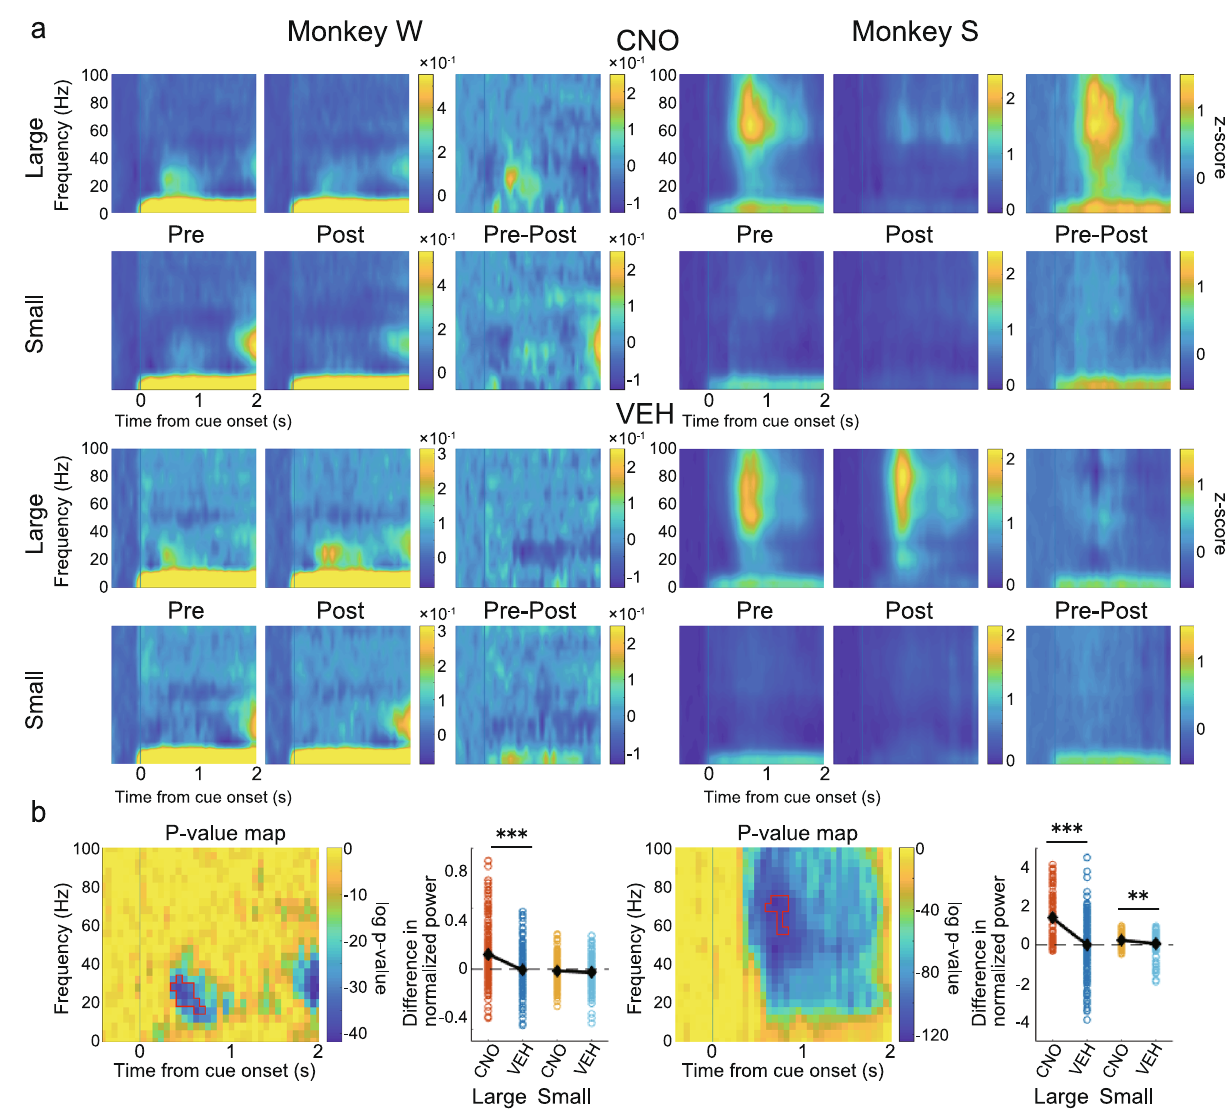
Fig. 4 Effects on spectrogram power in the LPFC after cue onset. a Normalized and averaged spectrograms of LFPs from electrodes in the LPFC for Monkey W (Left) and Monkey S (Right), divided into large- and small-reward trials in the CNO (upper) and VEH (lower) condition. From left to right for each monkey, each spectrogram referred to Pre, Post, and their subtraction (Pre – Post). Color represents normalized power ( − 500 to 0 ms as baseline). Time 0 refers to the cue onset. b For each monkey: left: p -value map generated to extract time-frequency ROIs for statistical testing. Color represents log p - value obtained by comparing spectrograms in large- and small-reward trials. Areas surrounded by red lines indicate ROIs, which are the largest cluster among time-frequency data points having p -value in the bottom 5% (see “ Methods ” ); right: comparison of the effects of CNO/VEH administration (Pre – Post) on normalized power averaged within ROIs divided into large- and small-reward trials. Each dot refers to the subtracted power from each electrode channel. Black diamonds represent mean values. CNO clozapine N-oxide, VEH vehicle, LFP local fi eld potential, LPFC lateral prefrontal cortex, ROI region of